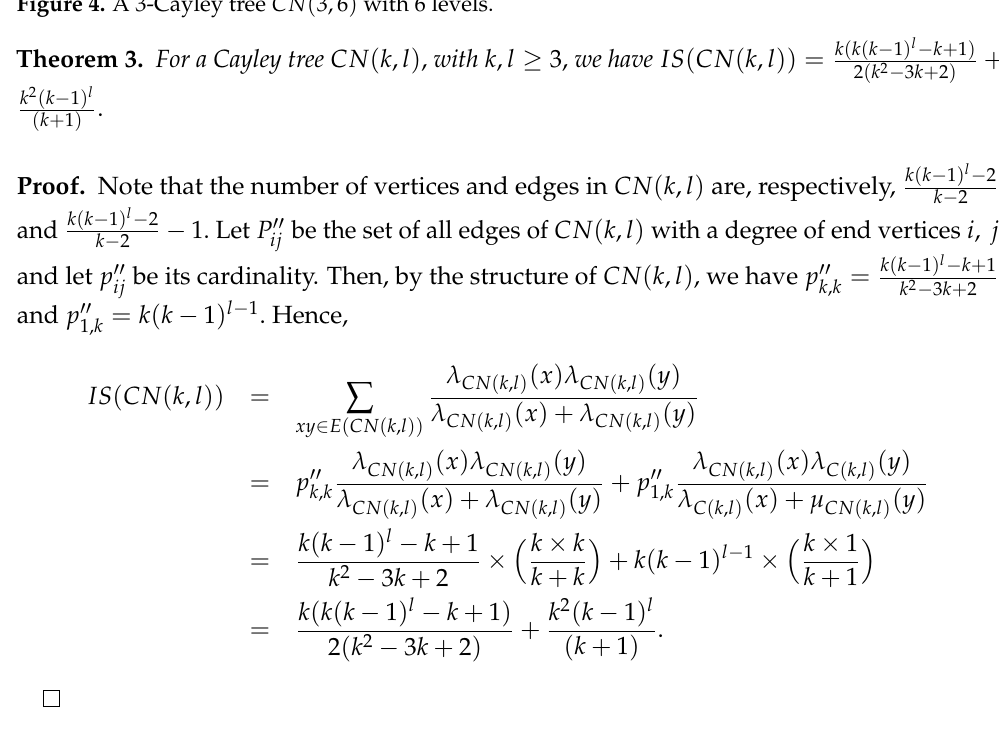
Figure 4. A 3-Cayley tree CN ( 3,6 ) with 6